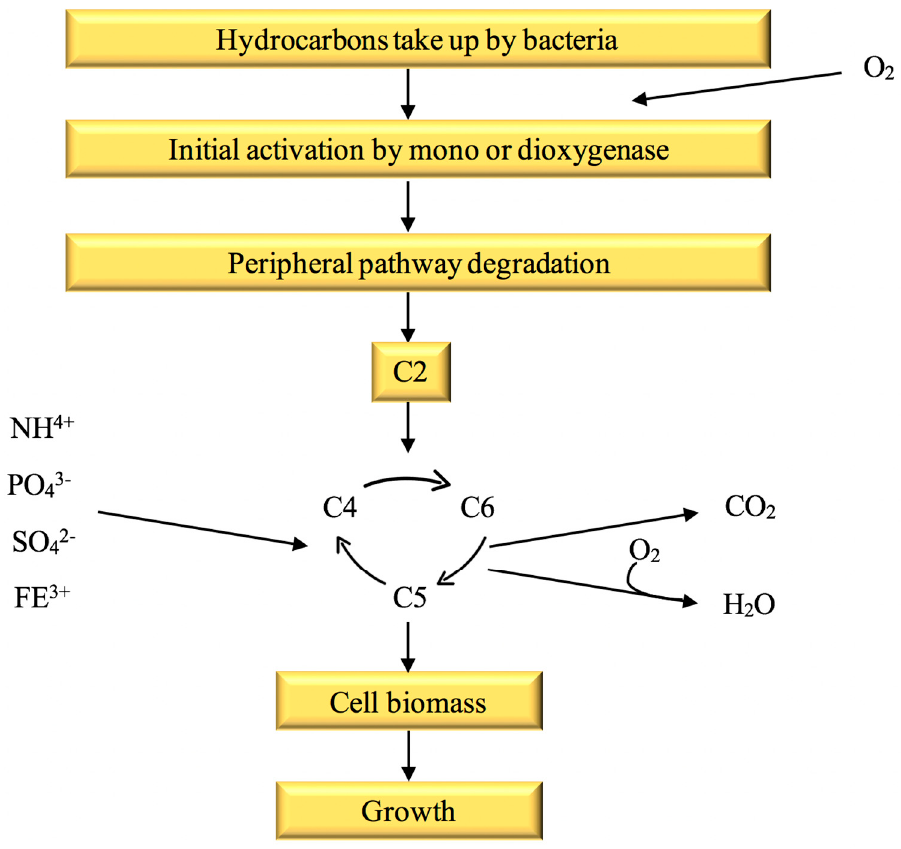
Figure 3. The principle of polyaromatic hydrocarbons (PAHs) aerobic degradation.